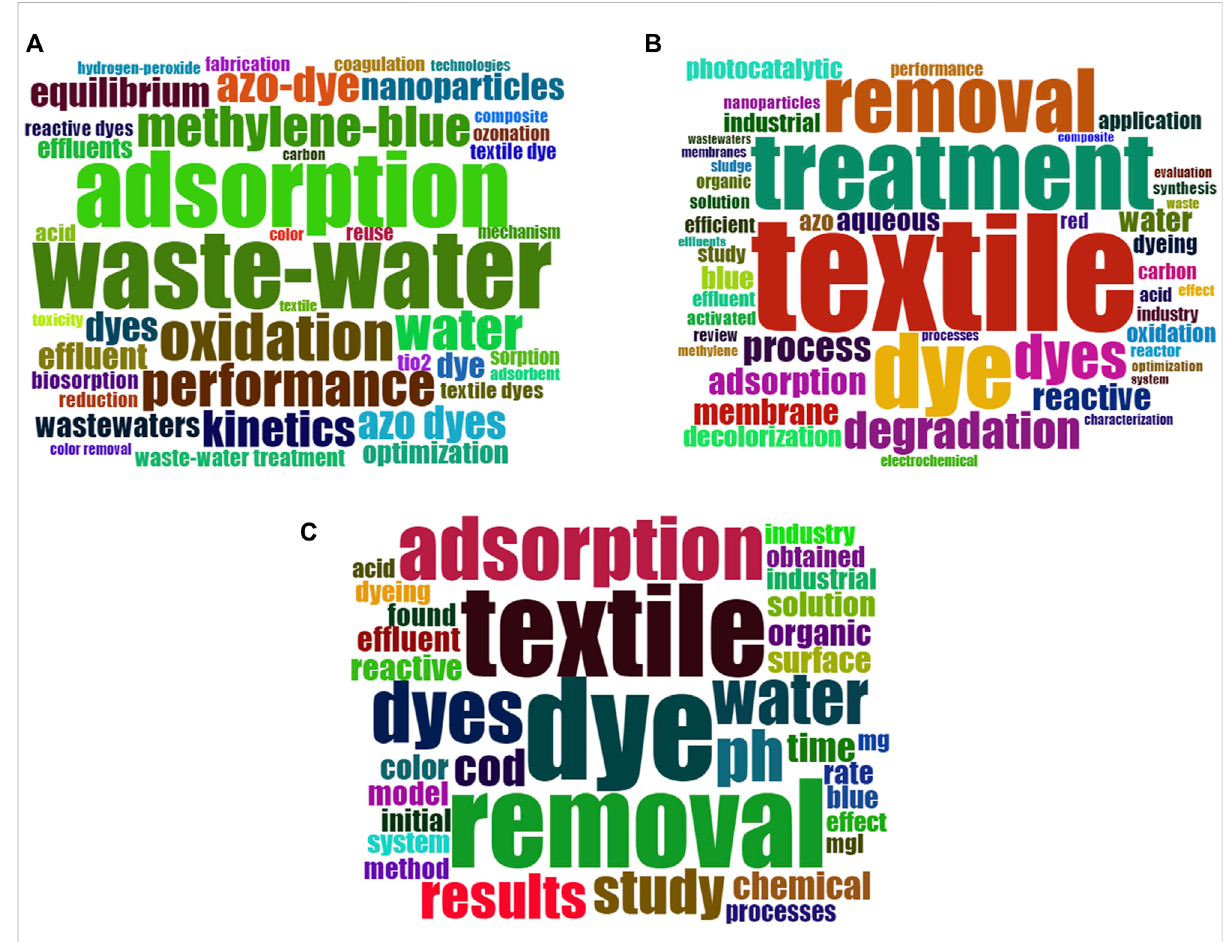
FIGURE 9 (A) WordCloud, words extracted from the keywords plus. The word “ wastewater ” was the leading word (B) . Wordcloud, extracted from titles. The word “ textile ” was the leading term (C) . Wordcloud from abstracts. The “ removal ” was the leading